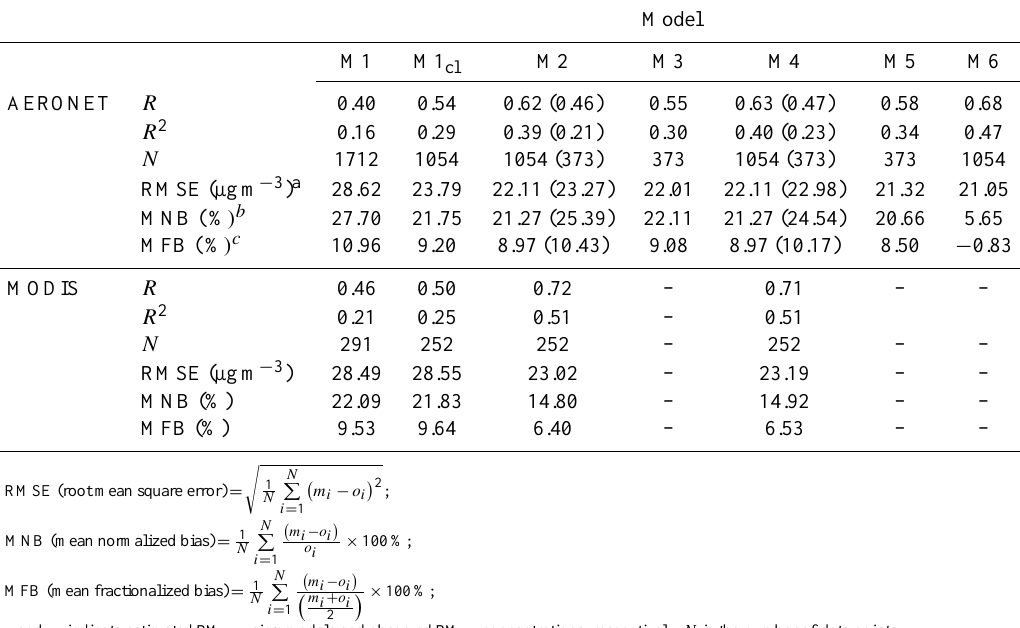
Table 5. Correlation coefficient ( R ), root mean square error (RMSE), mean normalized bias (MNB), and mean fractionalized bias (MFB) between measured PM 10 concentrations and those estimated by the different empirical linear models, using AERONET and MODIS data, during the DRAGON-Asia campaign period in Seoul. Numbers in parentheses represent results corresponding to the same number of data points as used in M3 and M5, when effective radius of aerosol data were